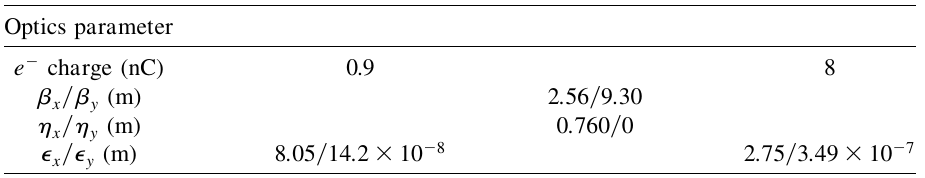
TABLE II. Optics parameters and transverse emittances at the BESM.